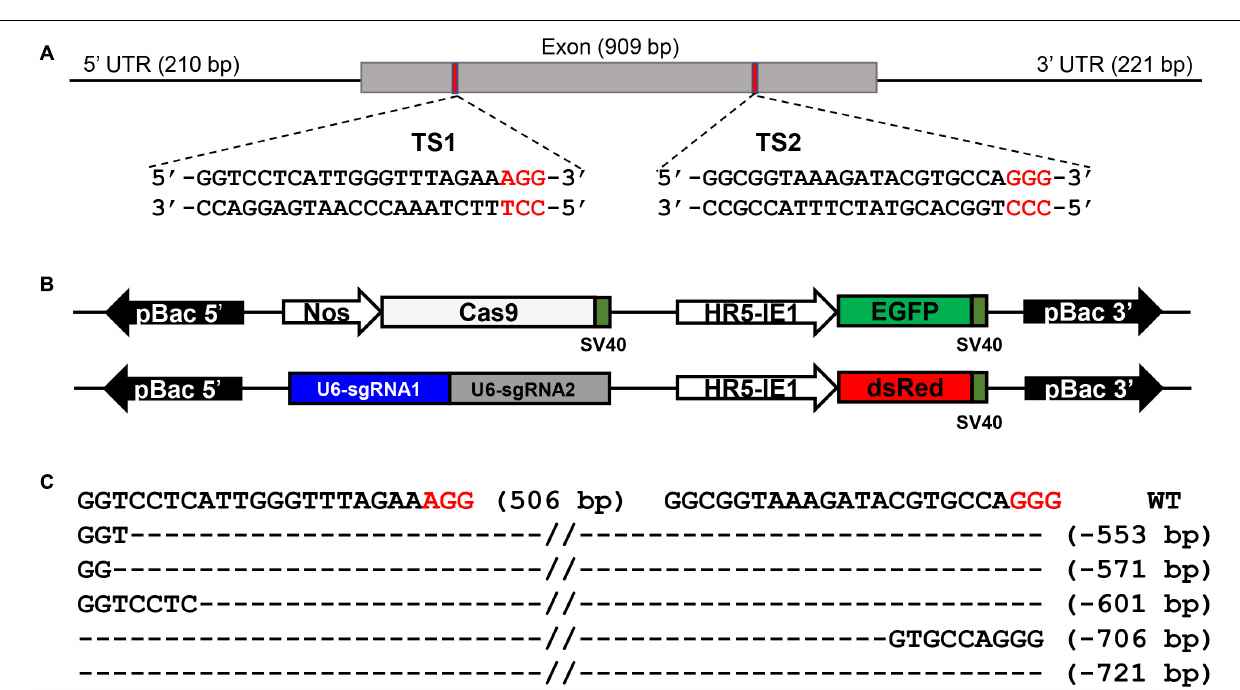
United States), and vectors were sequenced. The primers used for sequencing are listed in Table 1